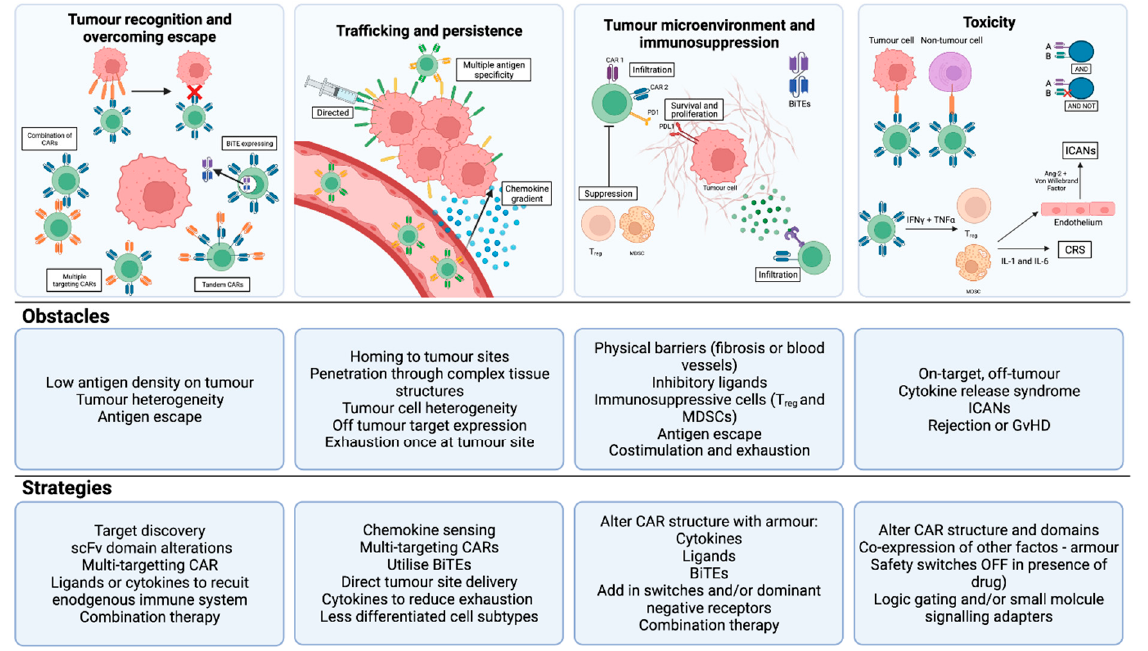
Figure 3. Solid tumour CAR T-cell challenges and potential strategies to overcome these. There are